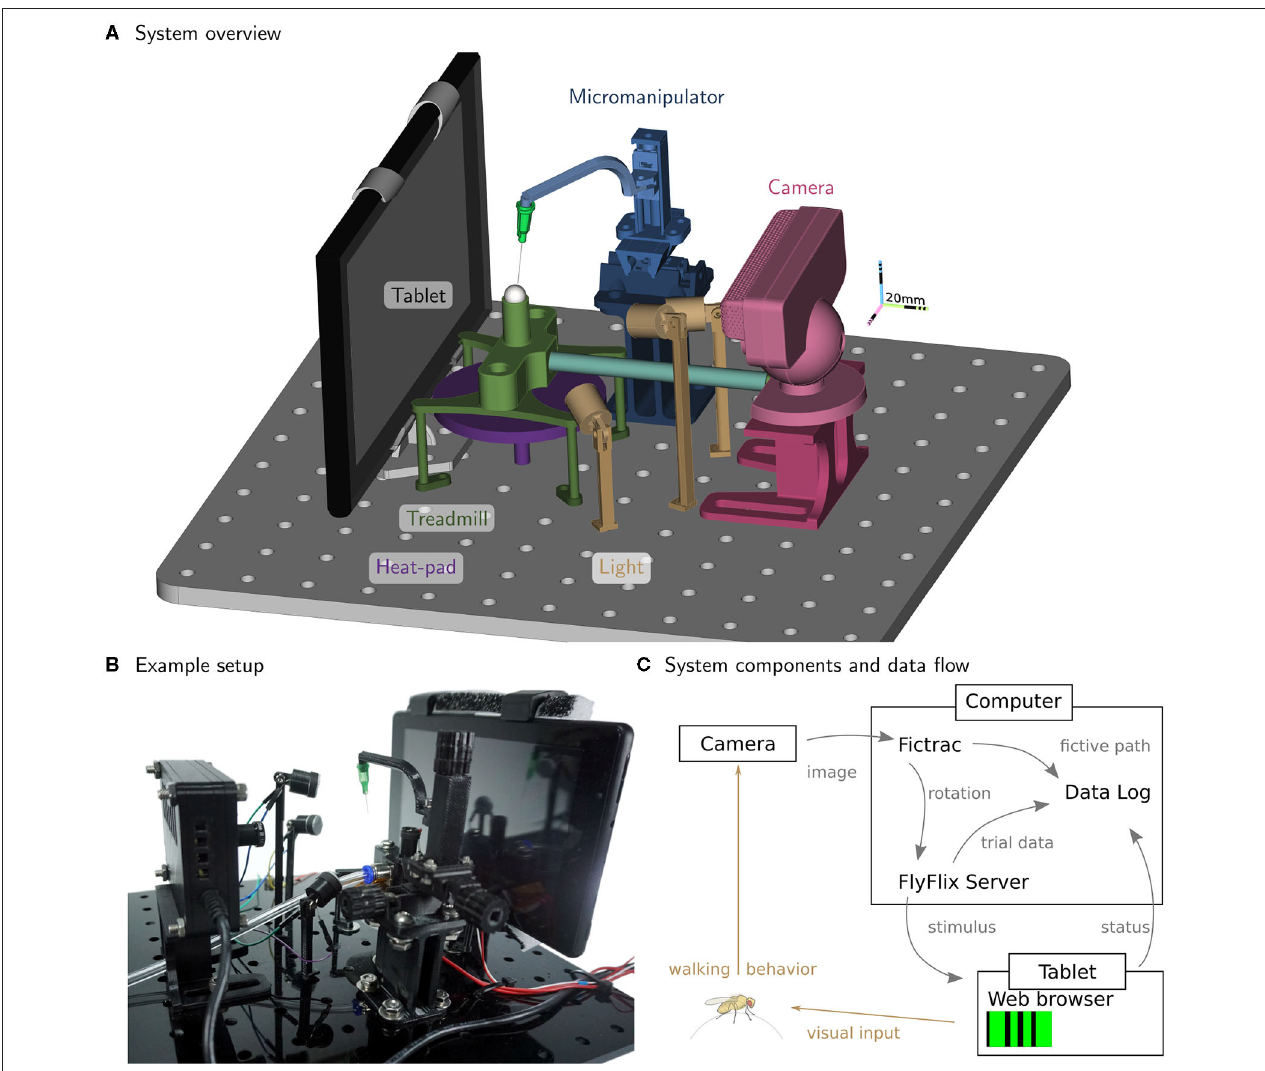
FIGURE 1 | Inexpensive treadmill setup for walking fly experiments. The rendering in (A) highlights the major components. A fly is tethered to the thin syringe tip (light-green cone) and positioned and held in place with the micromanipulator (in blue) facing the tablet (gray) while walking on the treadmill sphere (in white). The treadmill holder (in green) floats the sphere on a steady stream of air supplied by the tubing (light blue). The camera (in red) is used to track the sphere rotations, while adjustable lights (in yellow) illuminate the sphere. The temperature near the fly is controlled from below by the heat-pad (in purple). All components are mounted on a breadboard laser-cut from an acrylic plate. (B) A photograph of the setup in the lab. (C) The flow of information between the major functional modules. For closed-loop experiments, ball rotations from FicTrac are routed to FlyFlix for on-line stimulus